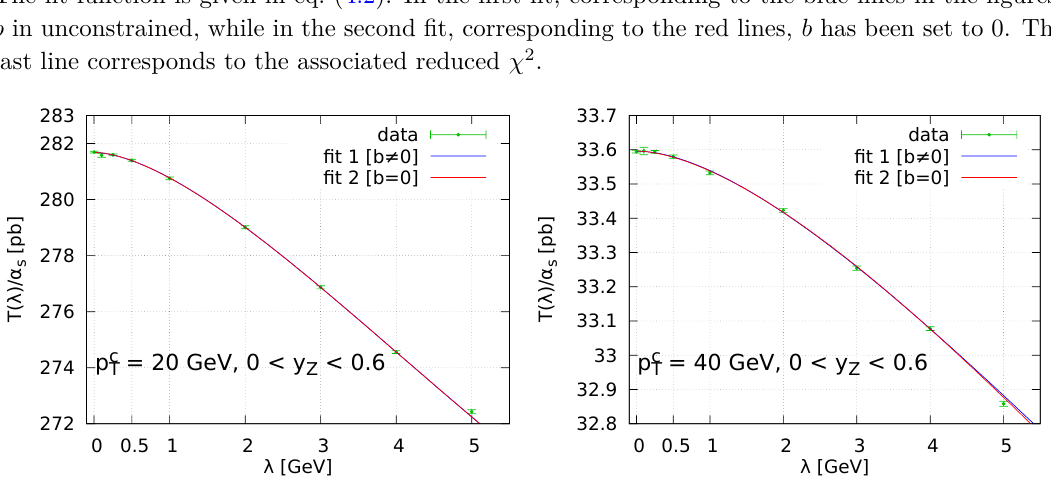
Figure 10 . As in figure 9, supplemented with a cut on the Z rapidity 0 < y